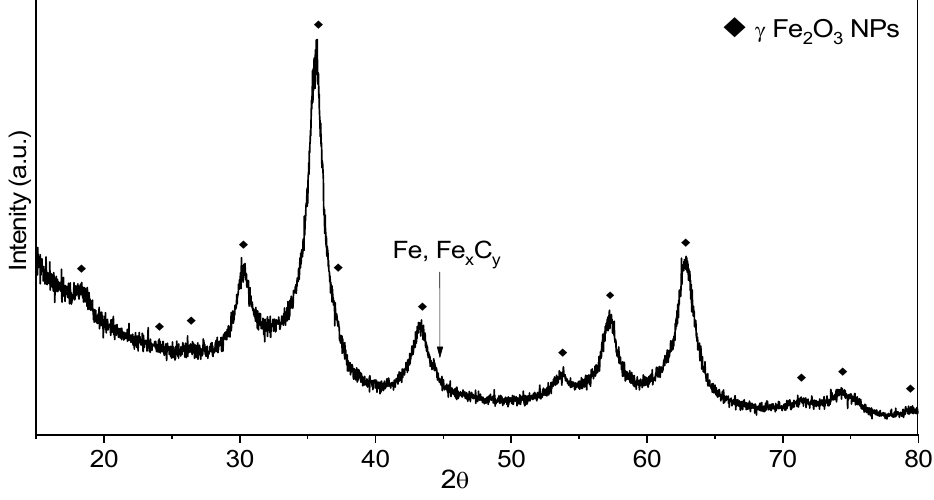
Figure 3. XRD patterns for as synthesized FeO1 nanoparticles (NPs).